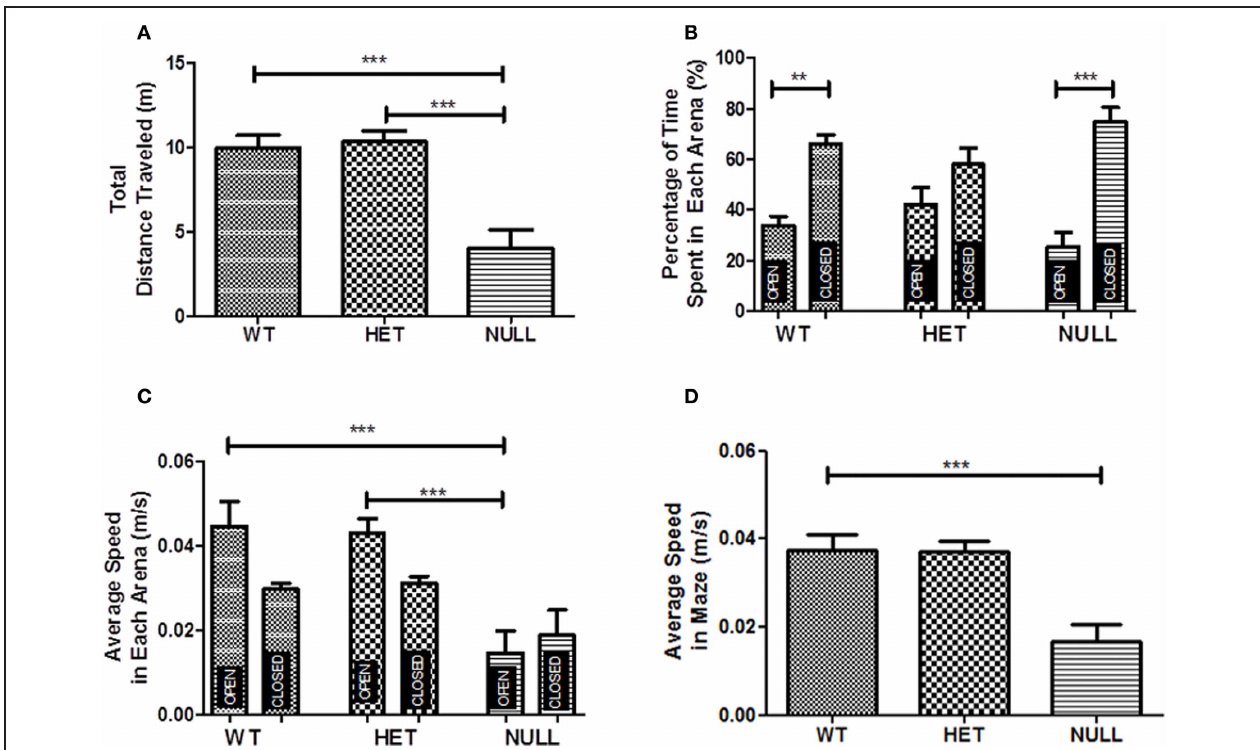
FIGURE 3 | Elevated zero maze. G α q knockout mice exhibit a hypoactive phenotype on the elevated zero maze and travel significantly less distance in the maze than their wildtype and heterozygous littermates ( A ; F ( 2 , 15 ) = 16 . 55, p < 0 . 001). There is not a significant difference between the genotypes in the percentage of time spent in the open areas